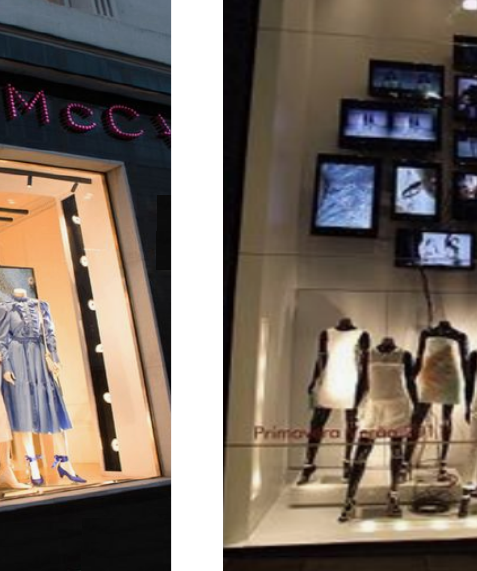
Figure 8. Digital display window style.